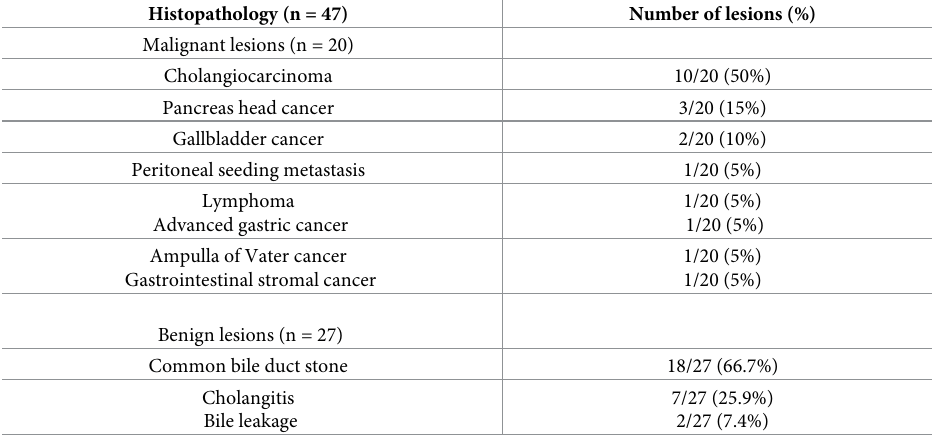
Table 1. Disease associated with biliary drainage in 47